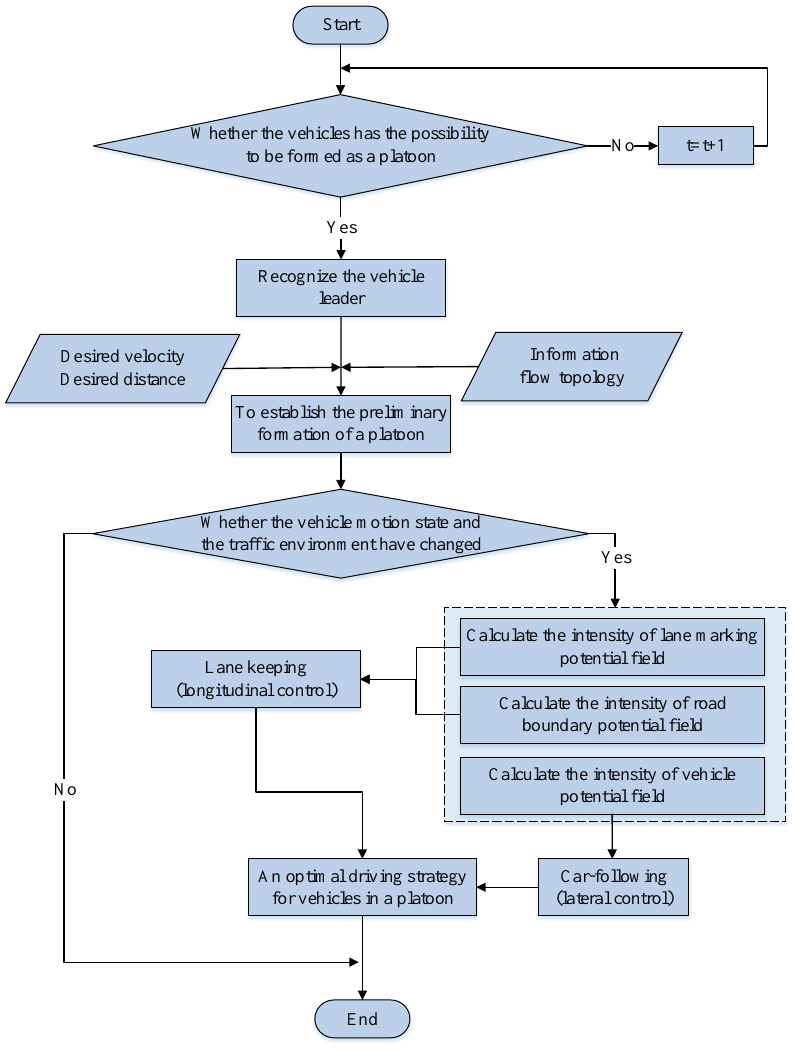
Figure 4. Flow chart of the platoon formation control strategy.